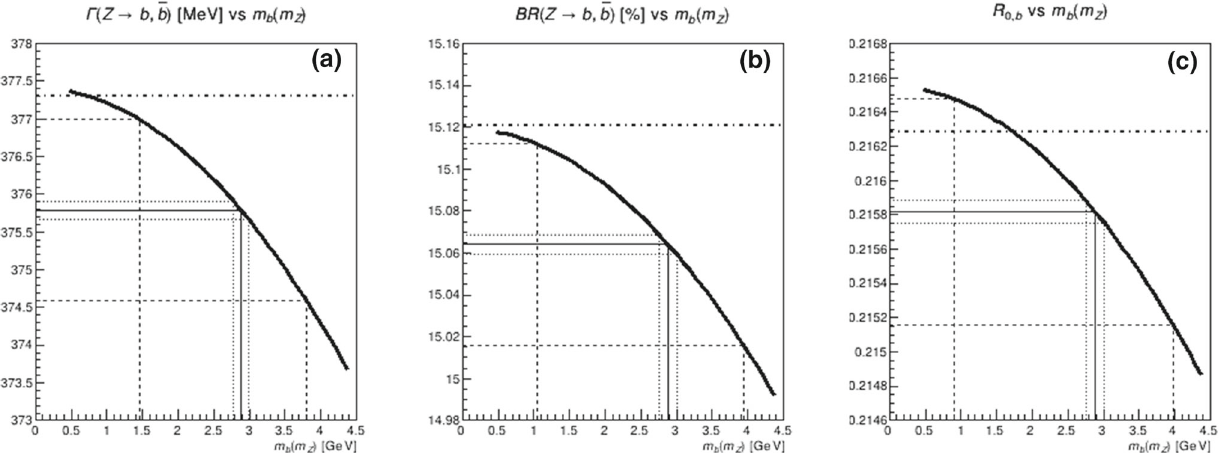
Fig. 1 Figures a – c show Gfitter predictions for the three observables as a function of m b ( m Z 0 ) . The horizontal dash-dotted lines indicate the measurements from LEP and SLD. The horizontal and vertical solid and dashed lines display the correspondence between a hypothetical